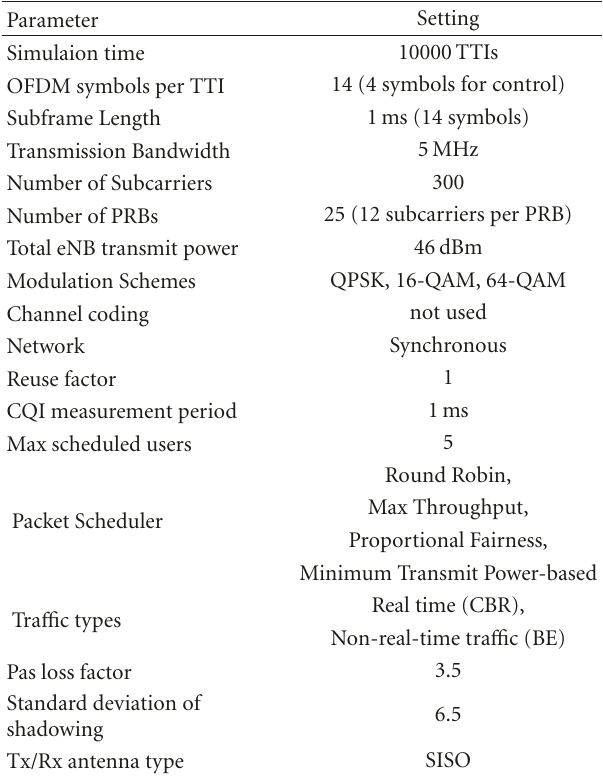
Table 1: Simulation